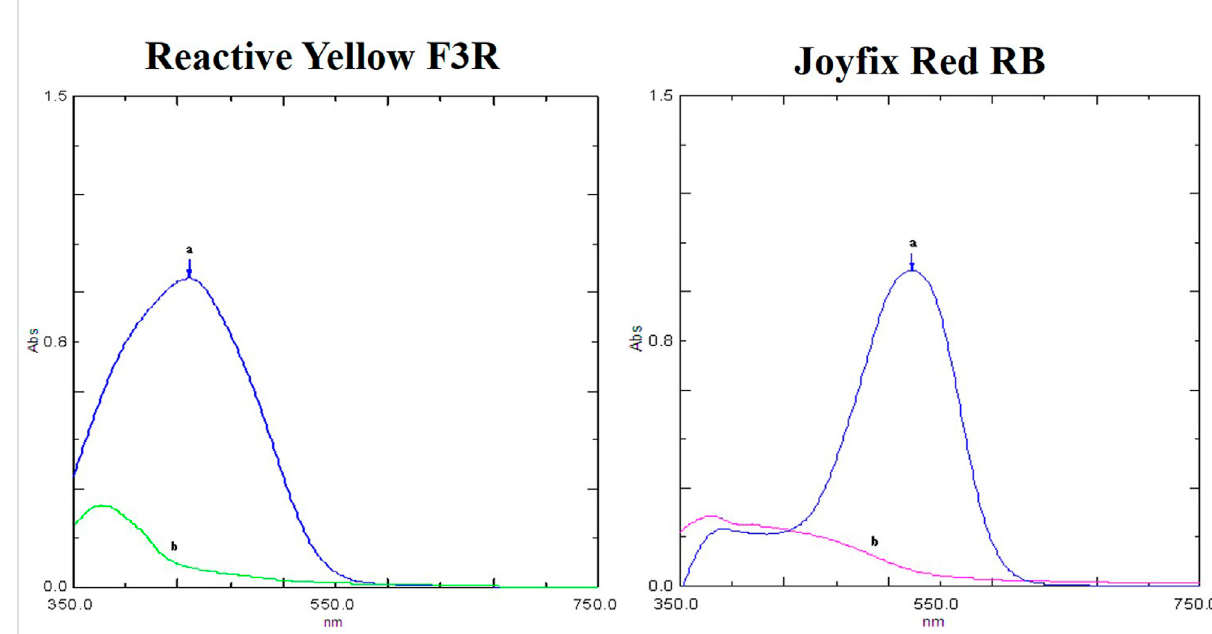
FIGURE 1 UV-vis spectra of dyes (A) before and (B) after decolorization by L. sphaericus MTCC 9523.